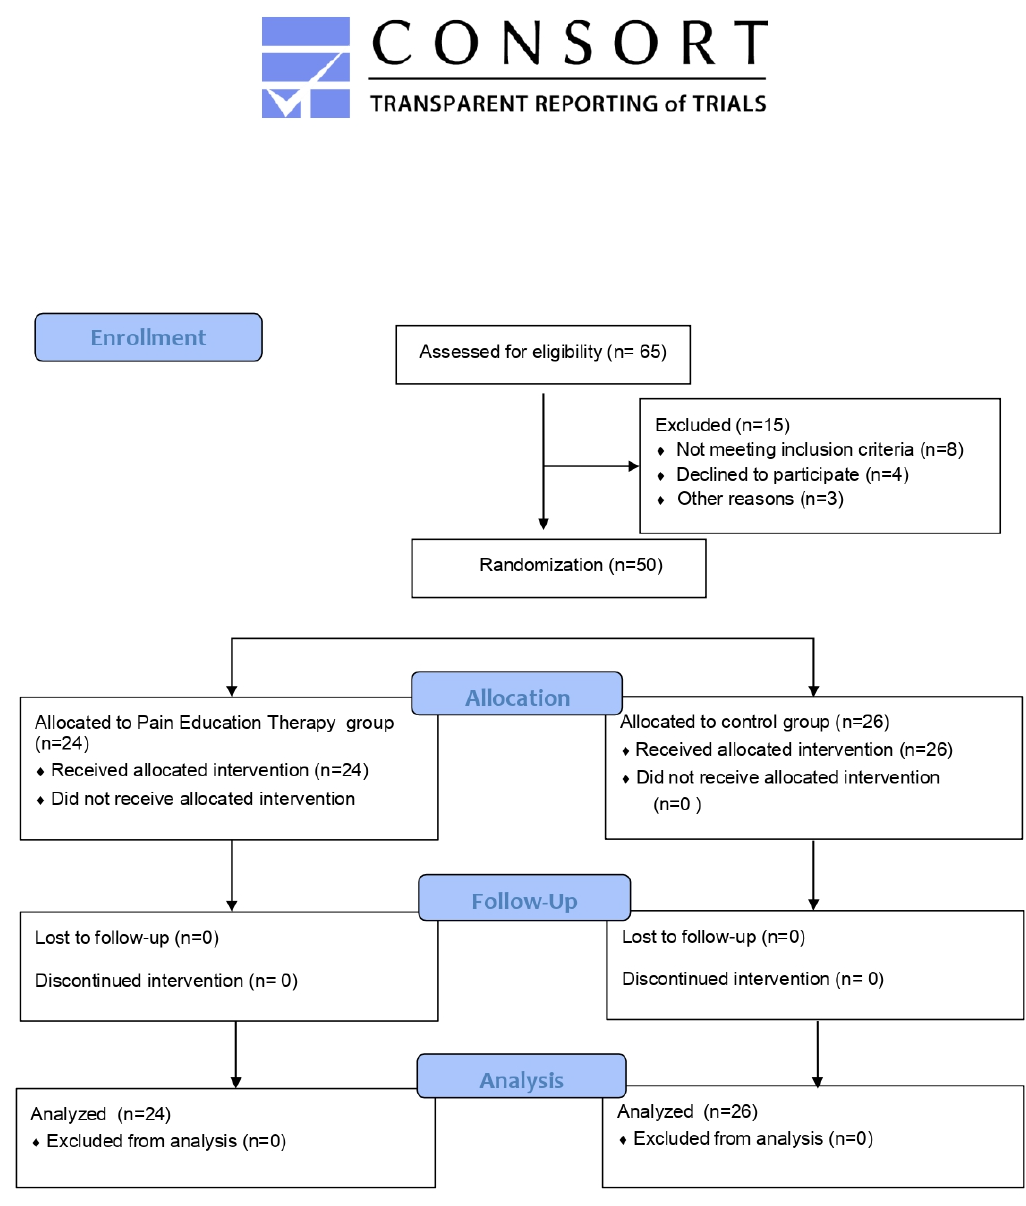
Figure 1. Flow diagram of the study.